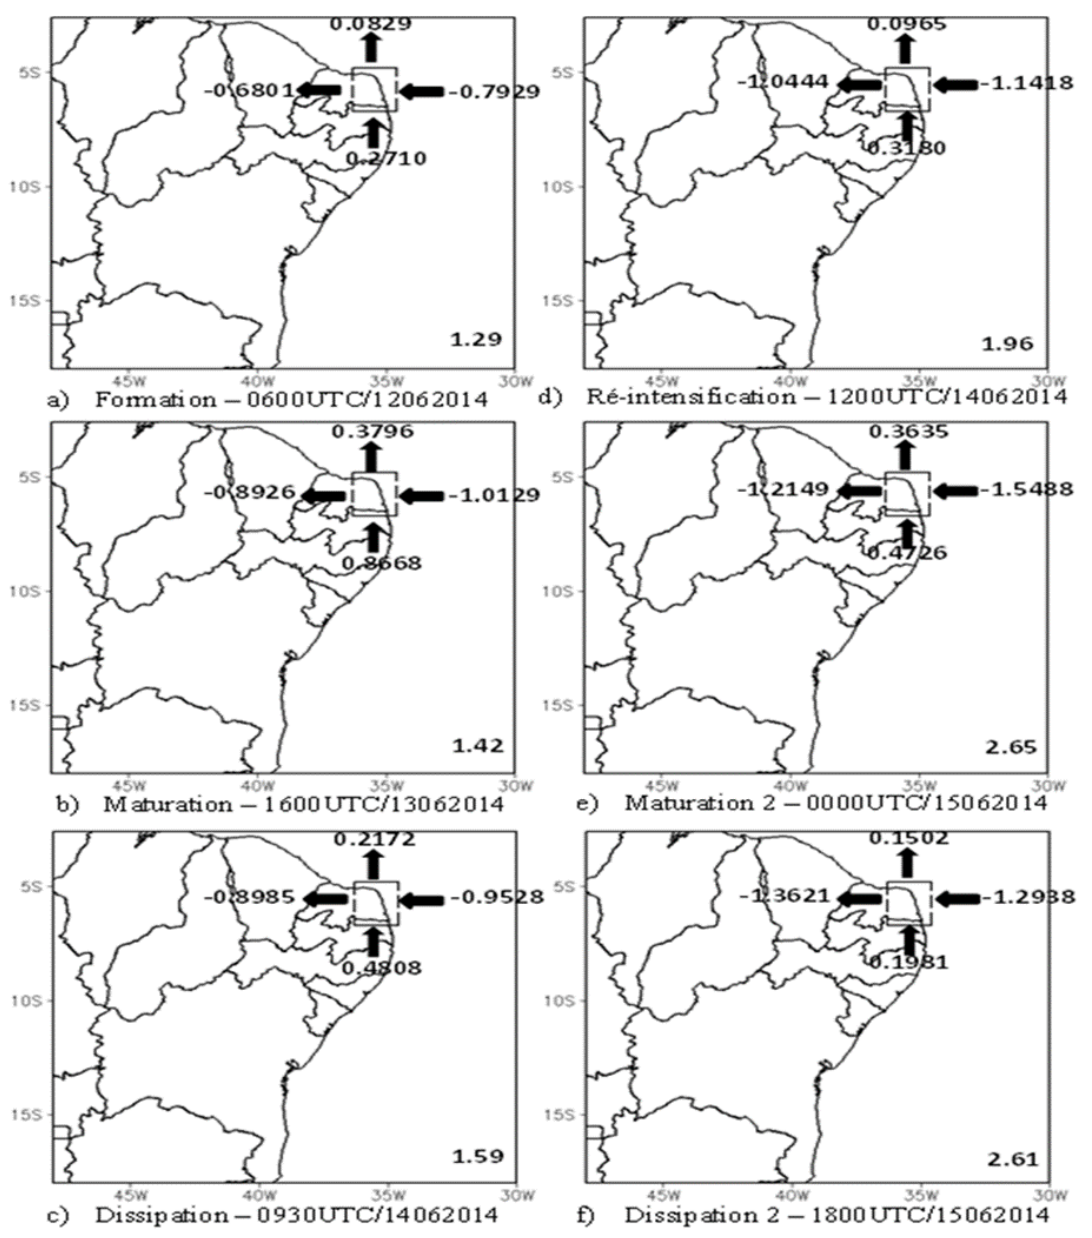
Figure 6. Moisture flux vertically integrated from 1000 to 300 hPa, along the representative edges of table 107